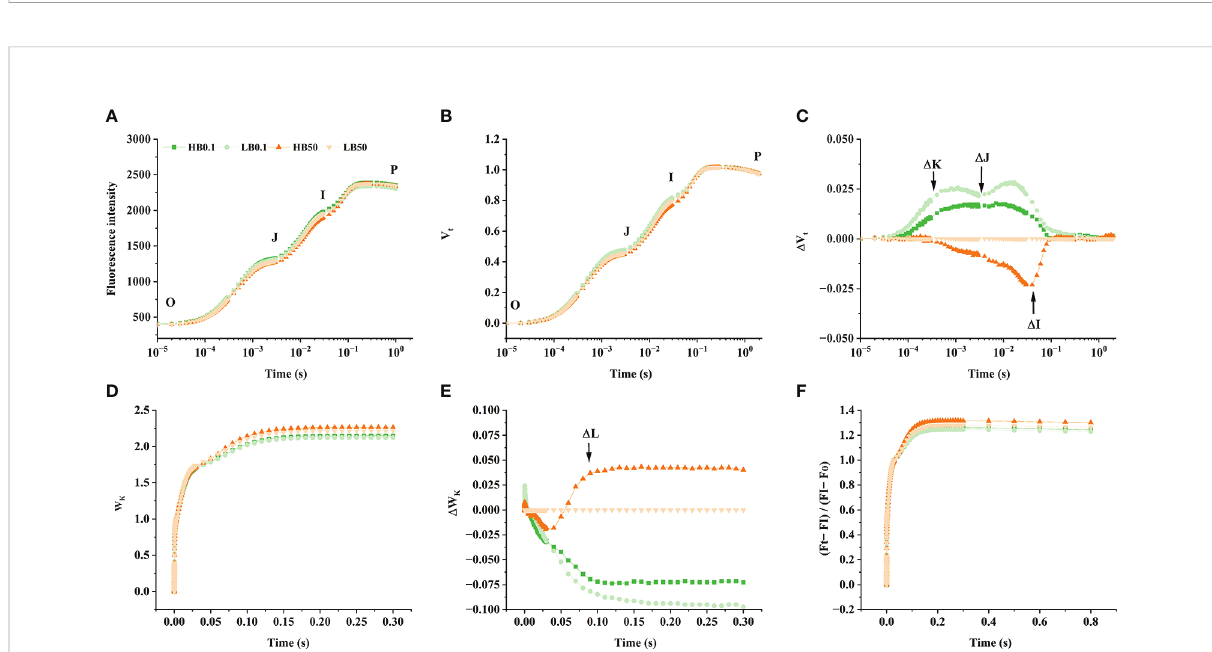
FIGURE 5 The effect of OJIP curve (A) , V t (B) , D V t: the difference of V t (C) , W k (D) , D W k : the difference of W k (E) and (F t -F I )/(F I -F 0 ) (F) of KWS1197(H) and KWS0143 (L) cultivars. The seedlings were treated with B de fi cient (0.1 m M H 3 BO 3 , B0.1) and B suf fi cient (50 m M H 3 BO 3 , B50)